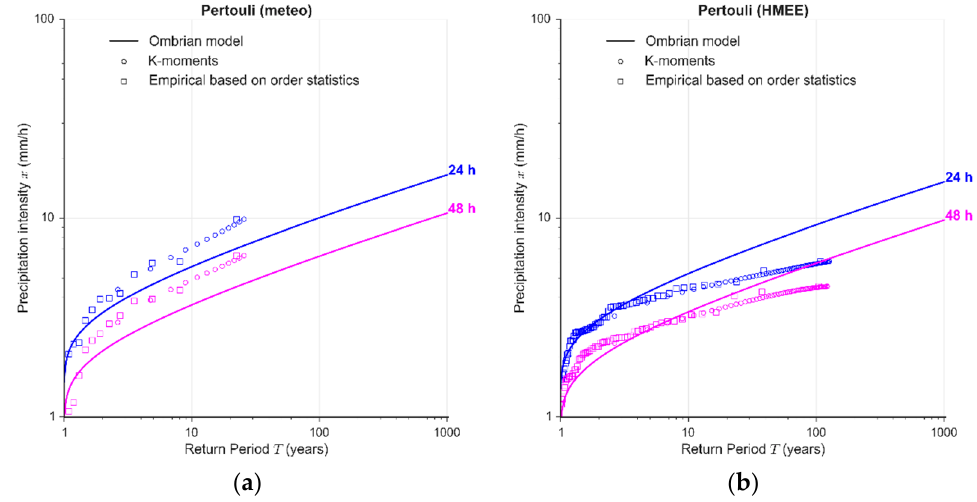
Figure 9. Example of the model fitting to two neighboring stations (from ( a ) meteo and ( b ) HMEE) at the Pertouli area with significant deviations in the stations’ recordings.